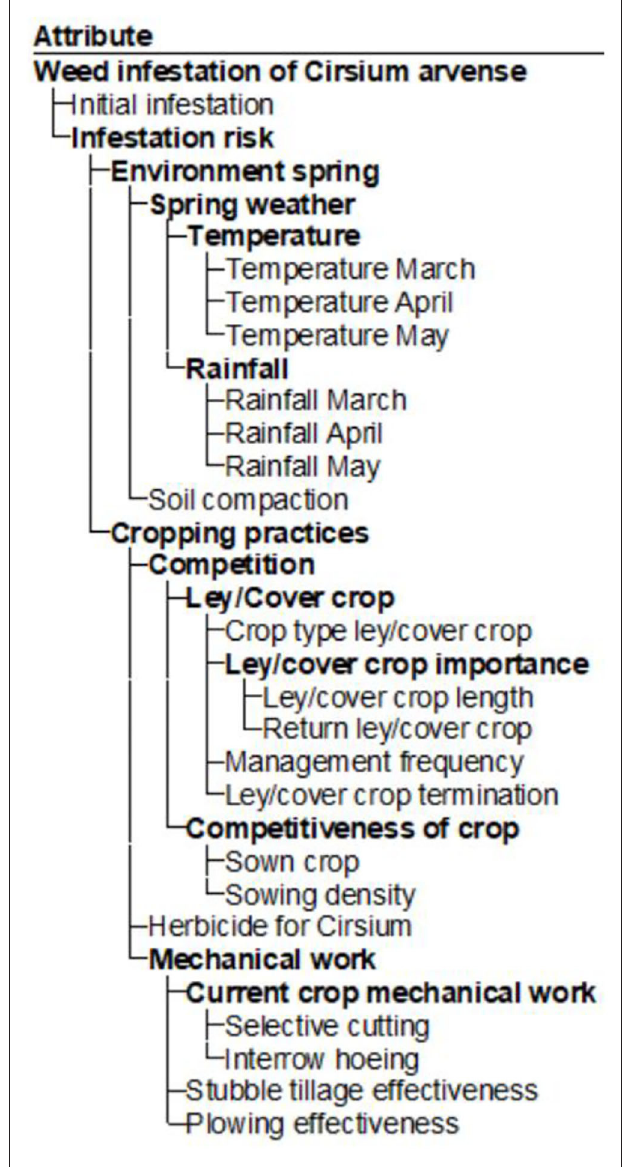
FIGURE 1 | Hierarchical structure of IPSIM-Cirsium. Bold and not in bold terms represent aggregated and basic attributes, respectively. (20 basic attributes and 13 aggregated attributes) (screenshot of the DEXi